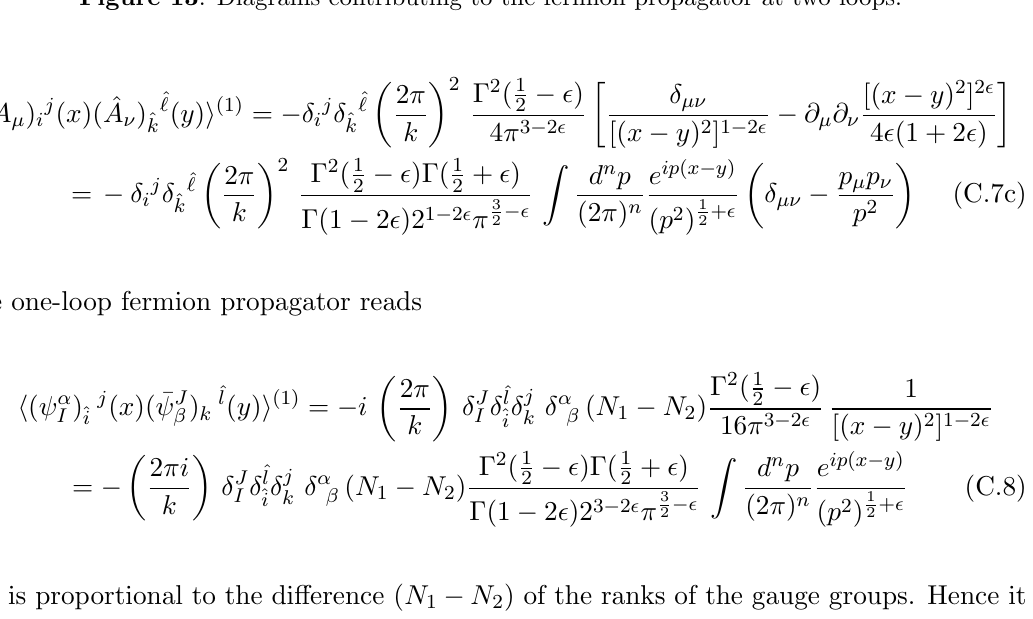
Figure 13 . Diagrams contributing to the fermion propagator at two